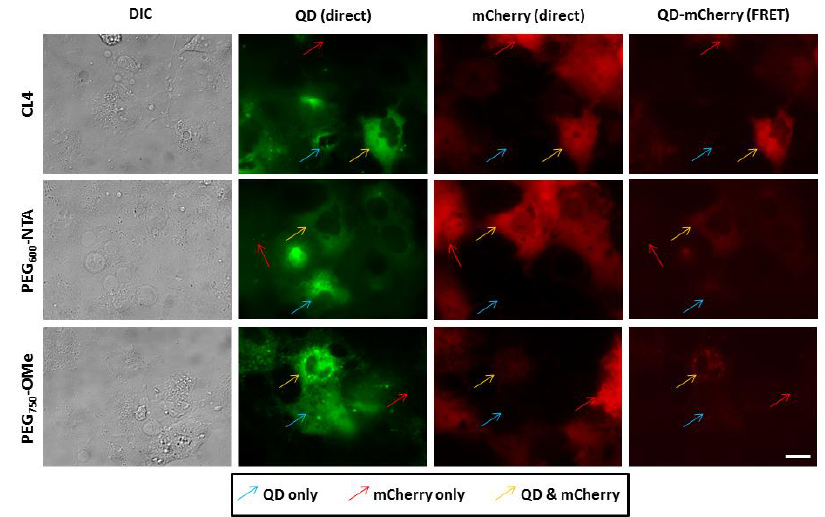
Figure 3. Cytosolic assembly of QDs and mCherry. COS-1 cells expressing His 6 -terminated cytosolic mCherry proteins were microinjected with QDs coated with CL4, PEG 600 -NTA and PEG 750 -OMe. Fields were specifically imaged where cells contained mCherry only (red arrow), QDs only (blue arrow) or both QD and mCherry (yellow arrow) to allow for the appropriate FRET imaging controls. Note the level of efficient FRET present in cells injected with the CL4 QDs, with slightly less efficient FRET observed in cells injected with PEG 600 -NTA QDs. PEG 750 -OMe QDs appeared to mediate the least efficient FRET with intracellular mCherry. Scale bar is 20 µm.